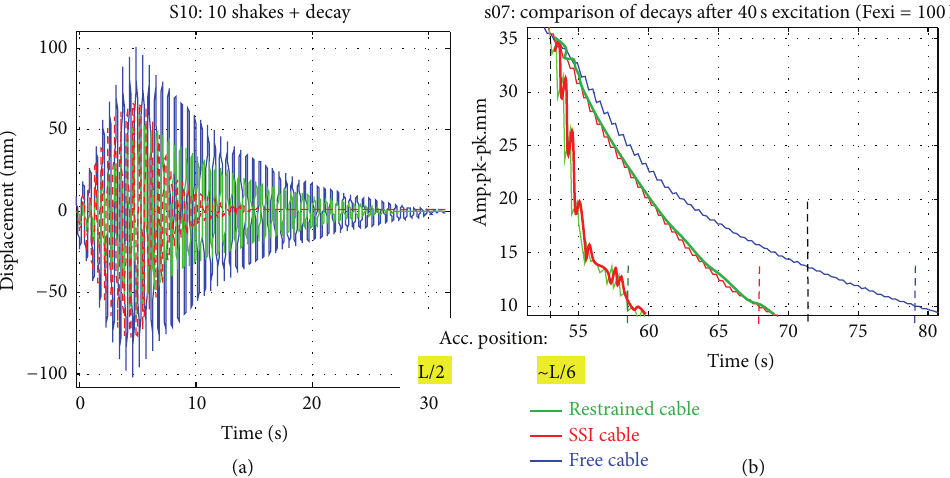
Figure 10: SSI damping effect during a free decay after a short (a) or long (b) loading period on mode number 1.